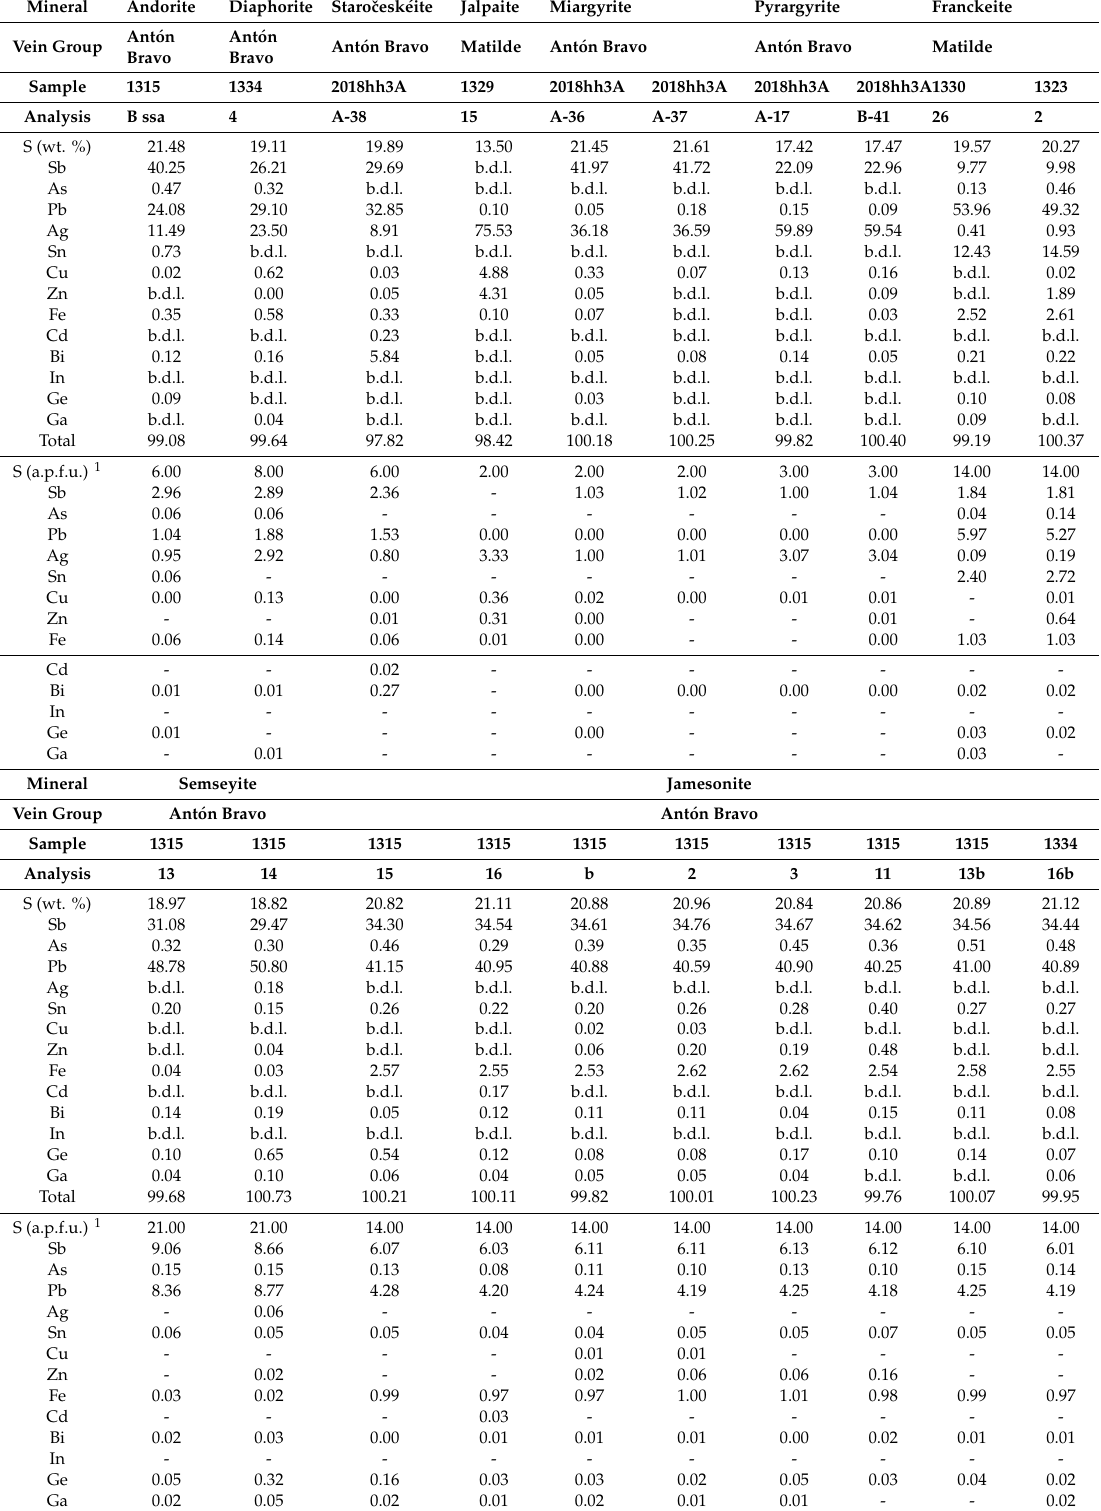
Table 6. Representative analyses of andorite, diaphorite, staroˇcesk é ite, jalpaite, miargyrite, pyrargyrite, franckeite, semseyite, and jamesonite from the Huari Huari district, including chemical composition and structural formulas normalized to S (electron probe microanalysis data). Lower detection limits are given in Table 2, except for Pb (d.l. = 0.03), Bi (d.l. = 0.04), Sb (d.l. = 0.04), and As (d.l. = 0.11). Mineral